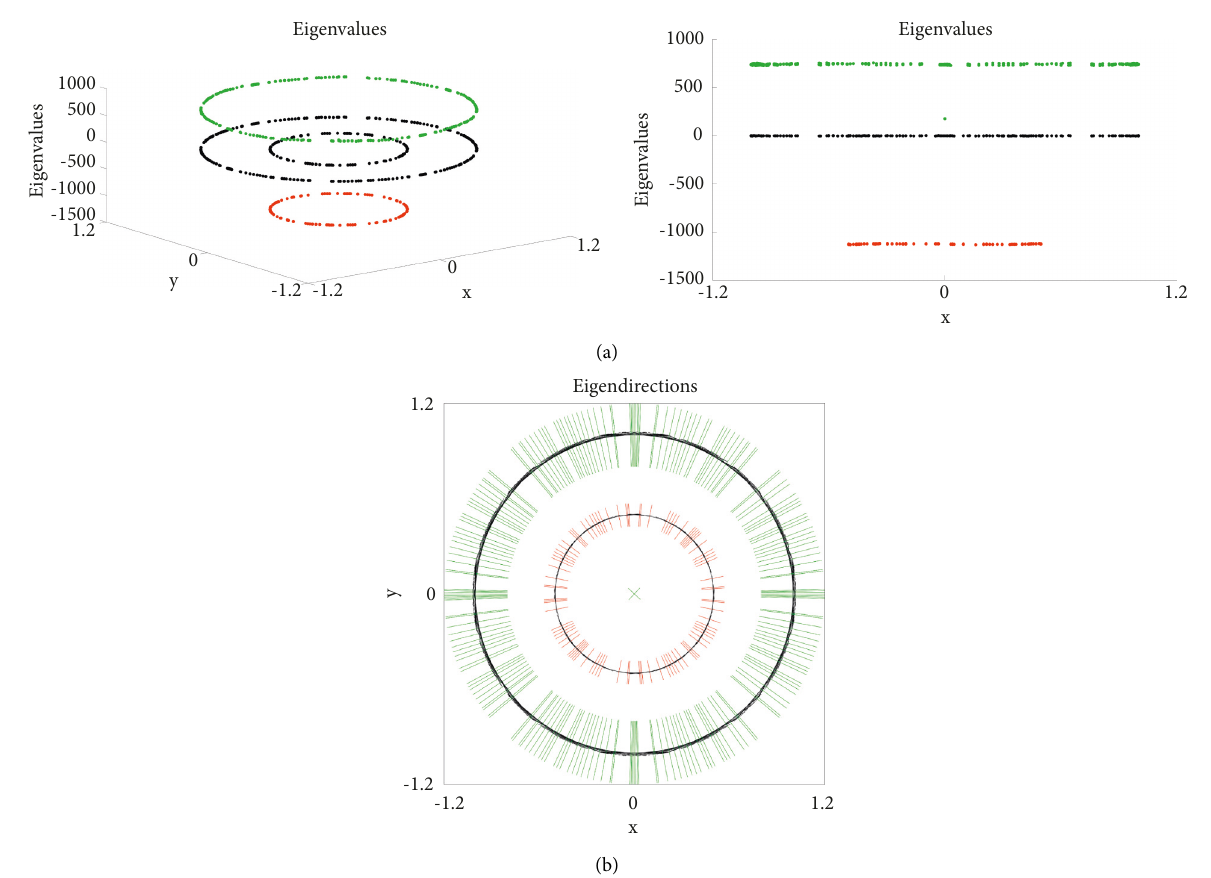
Figure 7: System (19). (a) The overestimation of the chain recurrent set 􏽥 X 0 � C chain recurrent set is plotted in green. It includes the underestimation C v, eigenvalue is negative and one zero. At the outer orbit, it includes points from 􏽥 X 0 if one eigenvalue is negative and one is zero. (b) Eigenvalues of the points in 􏽥 X 0 close to the critical point at the origin. All are positive, so the equilibrium has a 2-dimensional stable